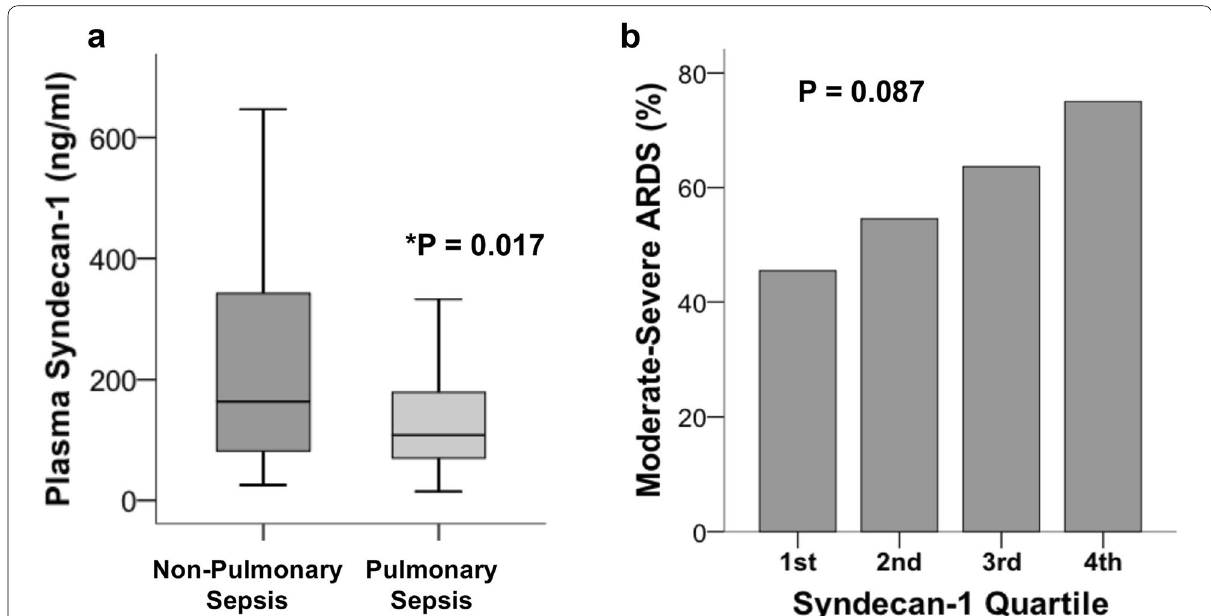
Fig. 2 Among patients with ARDS ( N 135), plasma syndecan-1 levels were significantly higher in patients with non-pulmonary sepsis compared = to those with pulmonary sepsis ( a , p 0.017 by Mann–Whitney U test). There was a trend for higher syndecan-1 levels to be associated with sever- = ity of ARDS in the subgroup ( n 56) of ARDS patients with non-pulmonary sepsis ( b , p =